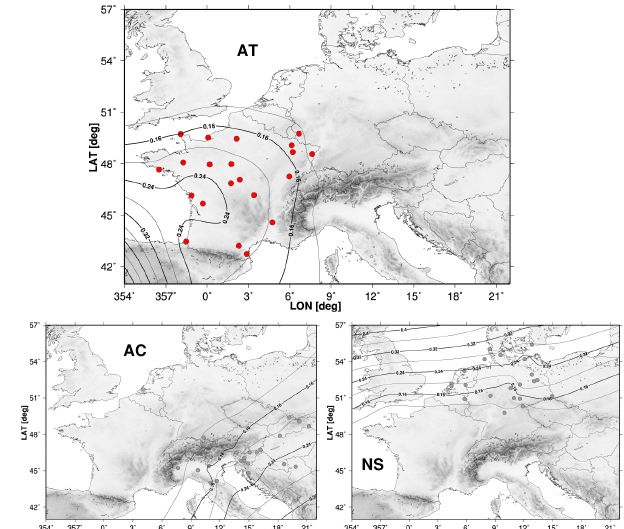
Figure 1. European areas (AT, AC and NS, see text) defined by Principal Component Analysis. Red dots in the upper panel denote locations of the 21 stations retained in the AT sub-domain. Loadings of Varimax rotated empirical orthogonal functions are also